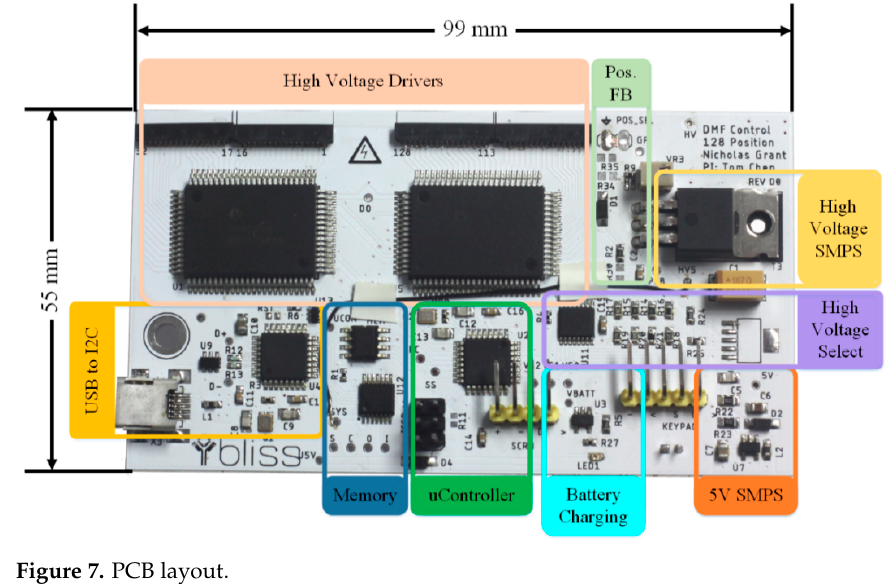
Figure 7. PCB layout.